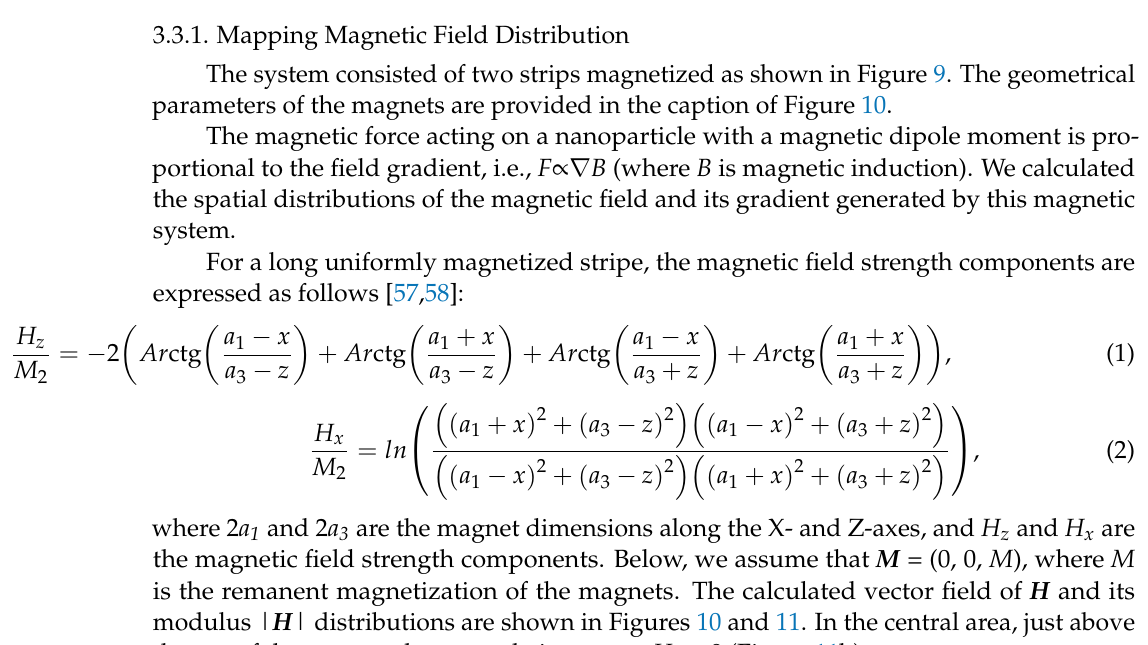
Figure 9. Calculated spatial distribution of ∇ B above the magnets. The blue arrows show the gradient directions, which are the same as the magnetic gradient force directions, while the white arrows represent the magnetization of BMNs in bacteria.